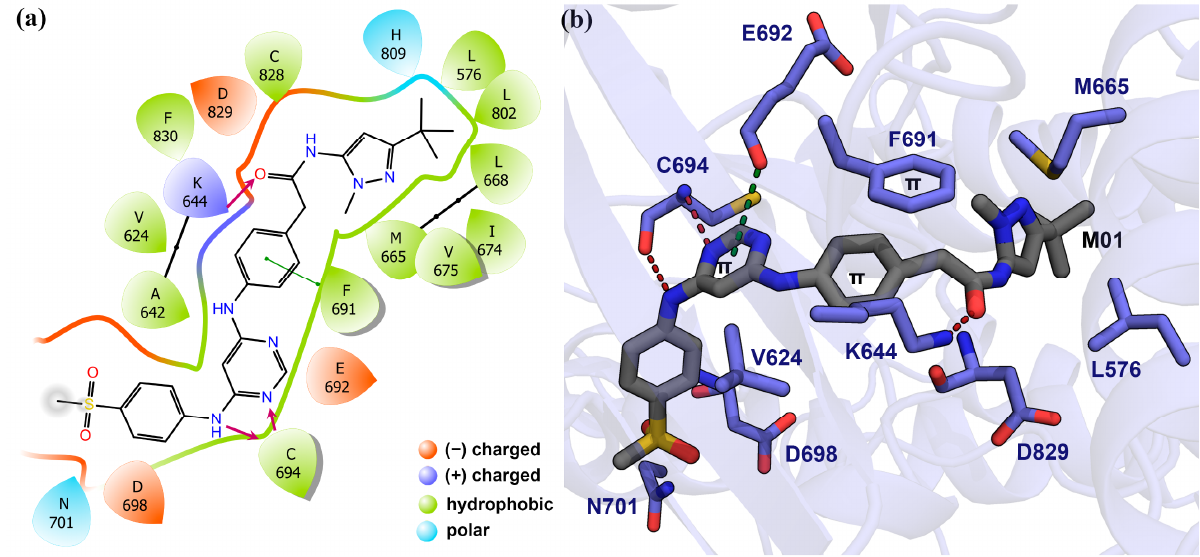
Figure 2. Molecular docking analysis of compound M01 and FLT3. ( a ) Compound M01 surrounded by the active site residues. The residues are illustrated based on their chemical properties in 2D representation. H-bonds are shown by magenta arrows. ( b ) Docking interaction of M01 with FLT3 residues. The H-bond interactions are shown by red dashed lines. The π–anion interaction is shown by green dashed lines.